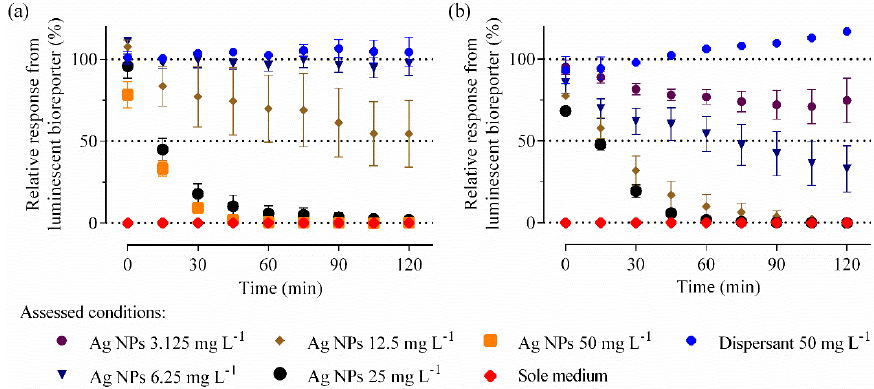
Figure 1. Real time monitoring of silver nanoparticle (Ag NP) toxicity in wastewaters. Relative luminescence output evolutions over time by Pseudomonas putida ( P. putida ) BS566::luxCDABE when challenged up to 200 mg·L −1 of Ag NPs in ( a ) crude and ( b ) final wastewaters from Site 2 are shown.